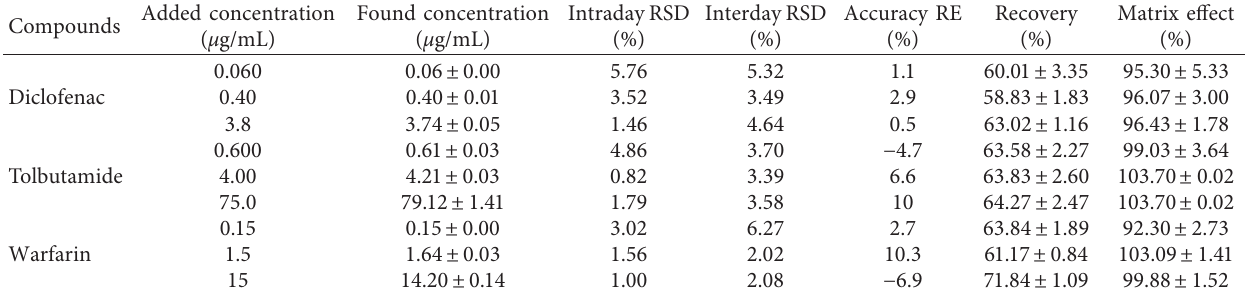
Table 5: Stability of diclofenac, tolbutamide, and warfarin in rat plasma.